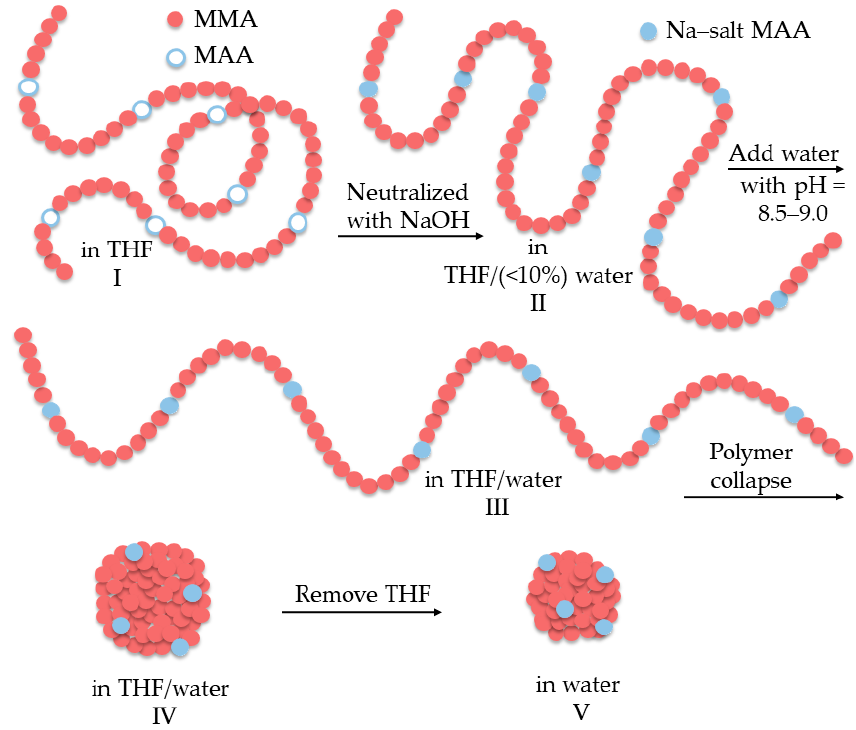
Figure 1. Schematics of the water reduction process and CUP formation [13].